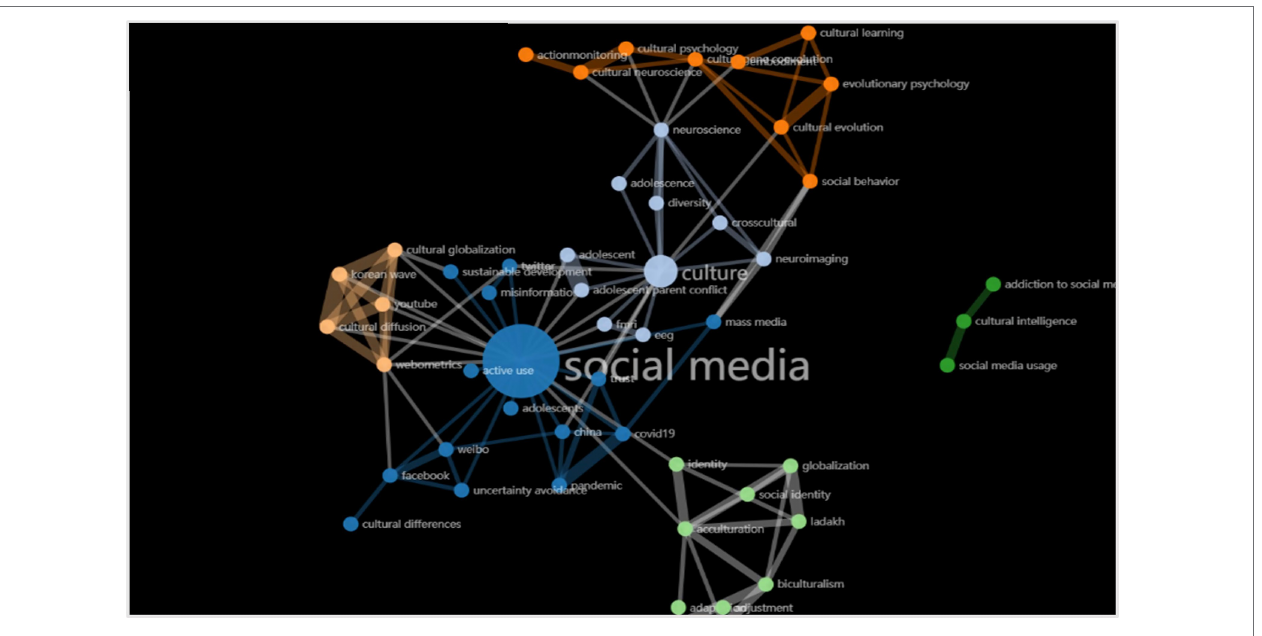
FIGURE 2 | Keywords knowledge